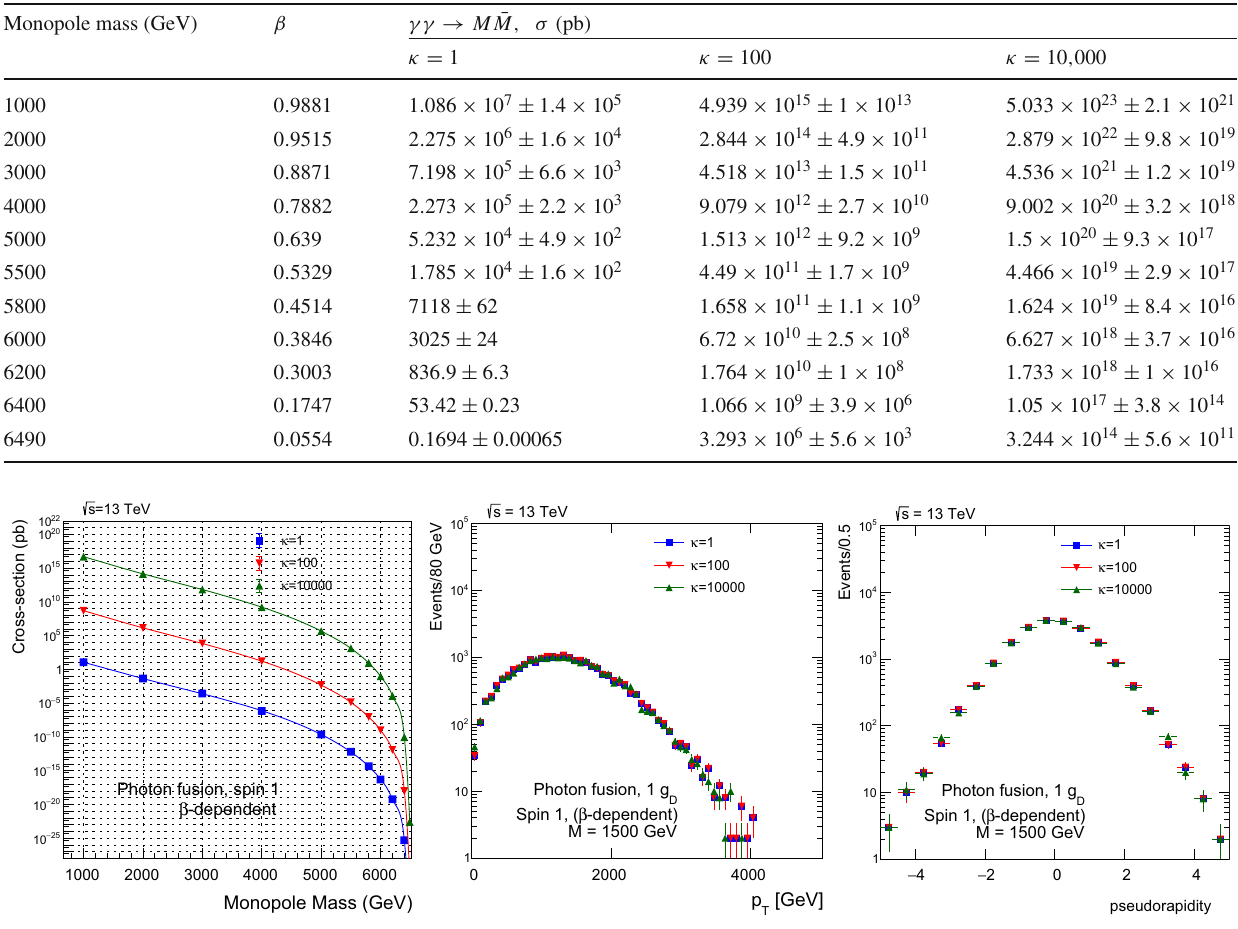
√ s γγ = 13 TeV for spin-1 monopole, β -dependent coupling and various values of the κ